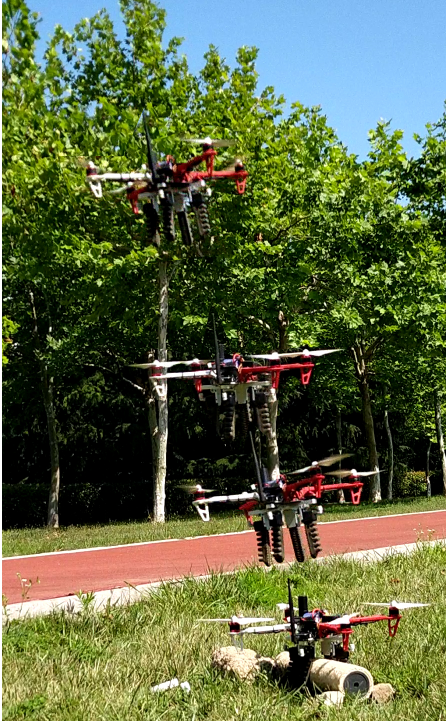
Figure 10. The proposed quadrotor helicopter system successfully landing on an outdoor non-flat surface with the support of the RBFNN controller.